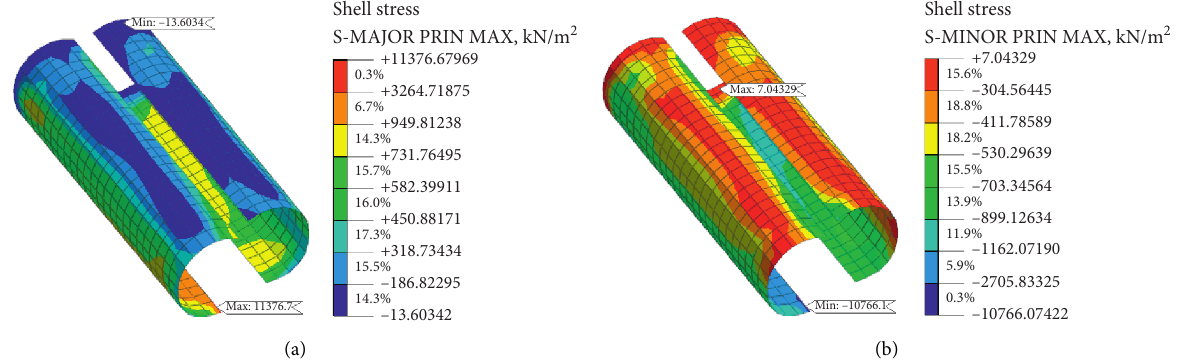
Figure 9: Maximum and minimum principal stress of the second liner.